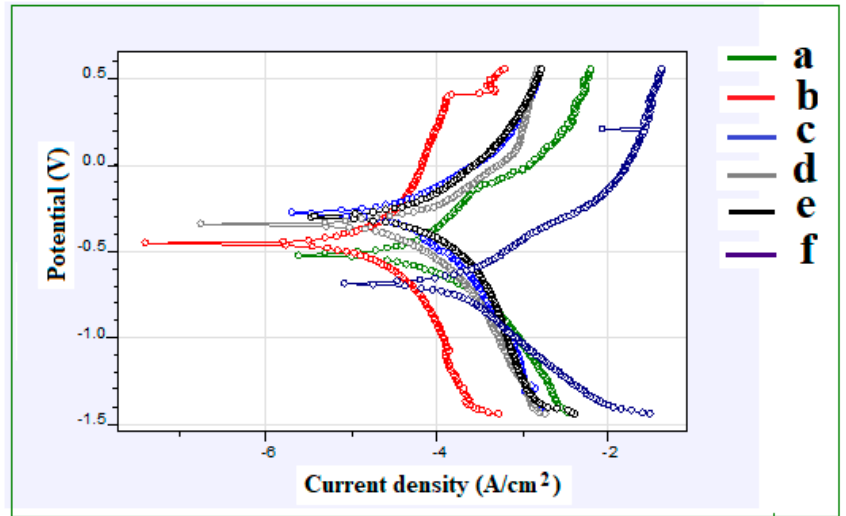
Figure 9. Potentiodynamic polarization curves of AlCrN monolayer coated samples. ( a ) Fe, ( b )